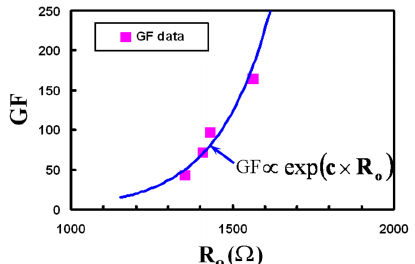
Figure 7. Plot of GF dependence on the initial resistance R 0 for 0, 1, 2, and 3 HR paths. The fitting line represents an exponential form to meet the experimental GF values. Coatings 2021 , 11 , x FOR PEER REVIEW